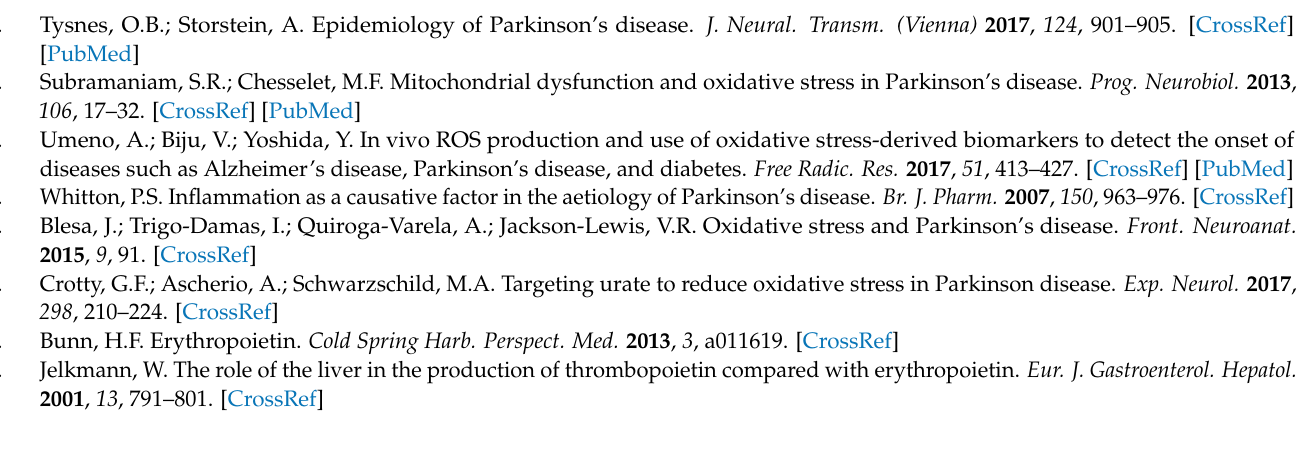
Blot analysis. Figure S3: Effect of EPO on cellular metabolism. Figure S4: Parkinsonism induction